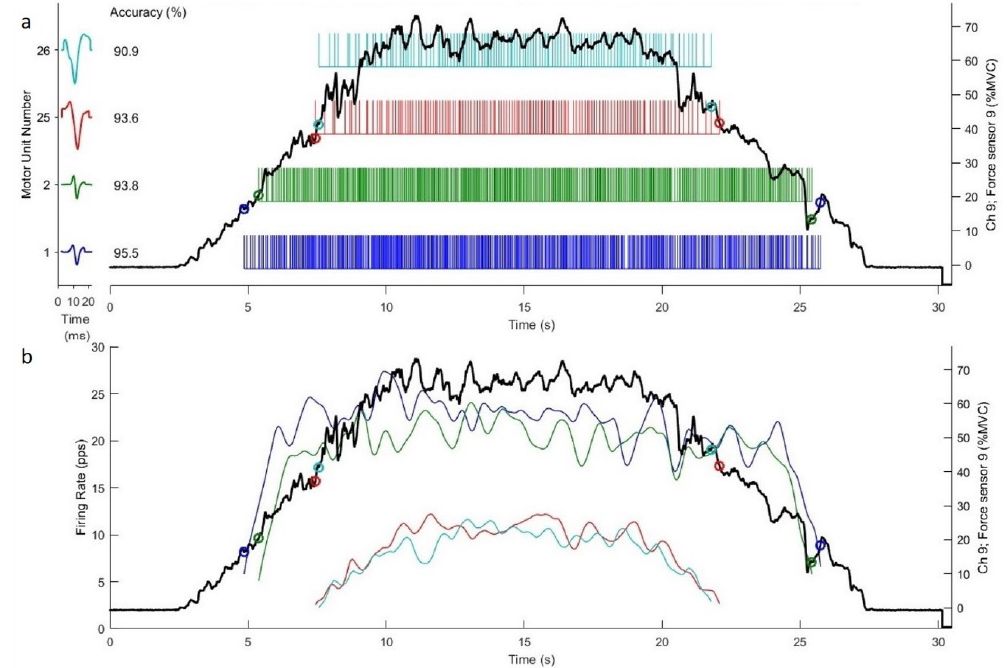
Figure 2. ( a ) Individual motor unit action potential trains during the isometric, trapezoid muscle action at 70% maximal voluntary isometric contraction (MVIC) intensity. Each vertical bar represents a motor unit firing. The solid black line is the subject’s force output. ( b ) Time-varying mean firing rate plots during the submaximal trapezoid isometric contraction. To enhance visual clarity, only the first two (blue and green circles) and last two (red and teal circles) recruited MUs have been displayed. Each colored line represents the mean firing rate (MFR) curve over time for an individual MU of the biceps brachii muscle. The mid-6-s of the trapezoid contraction is selected for MU MFR calculation.